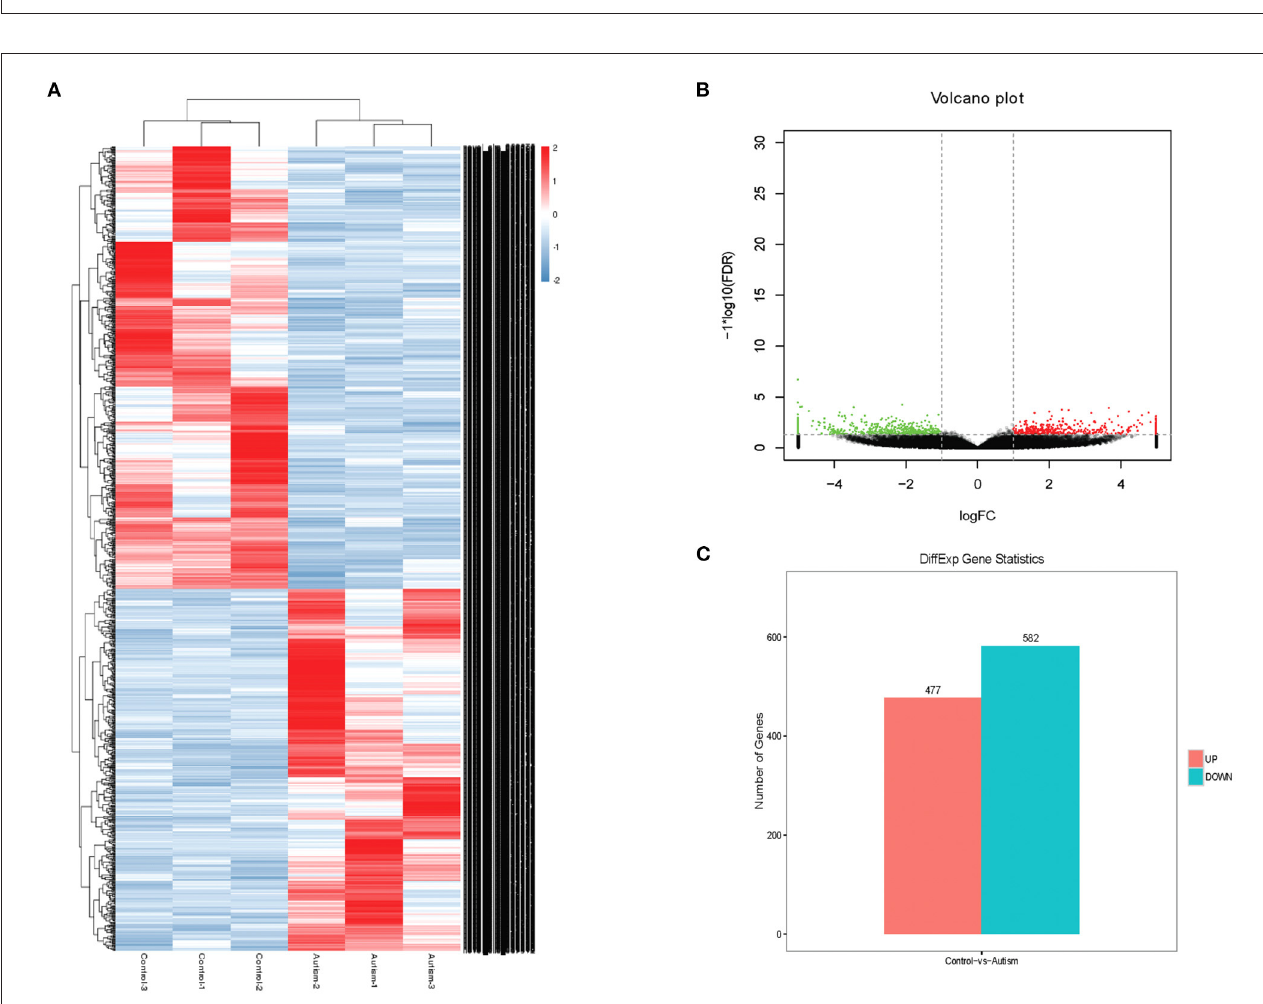
FIGURE 2 | Differentially expressed circRNAs in brain from autism mice. (A) Heat map. (B) Volcano plots. (C) The number of differentially expressed circRNAs in a mouse model of autism.